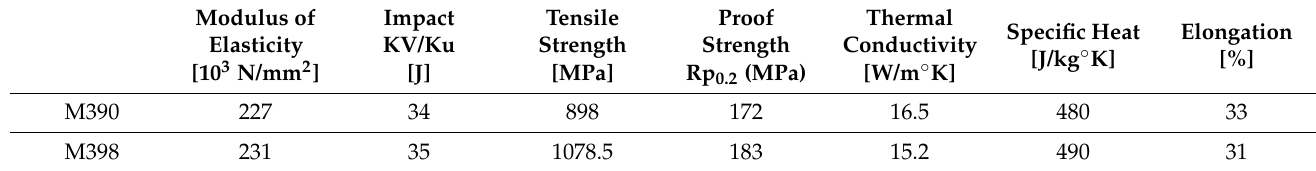
Table 2. Basic mechanical properties of the investigated M390 and M398 steel. [11].